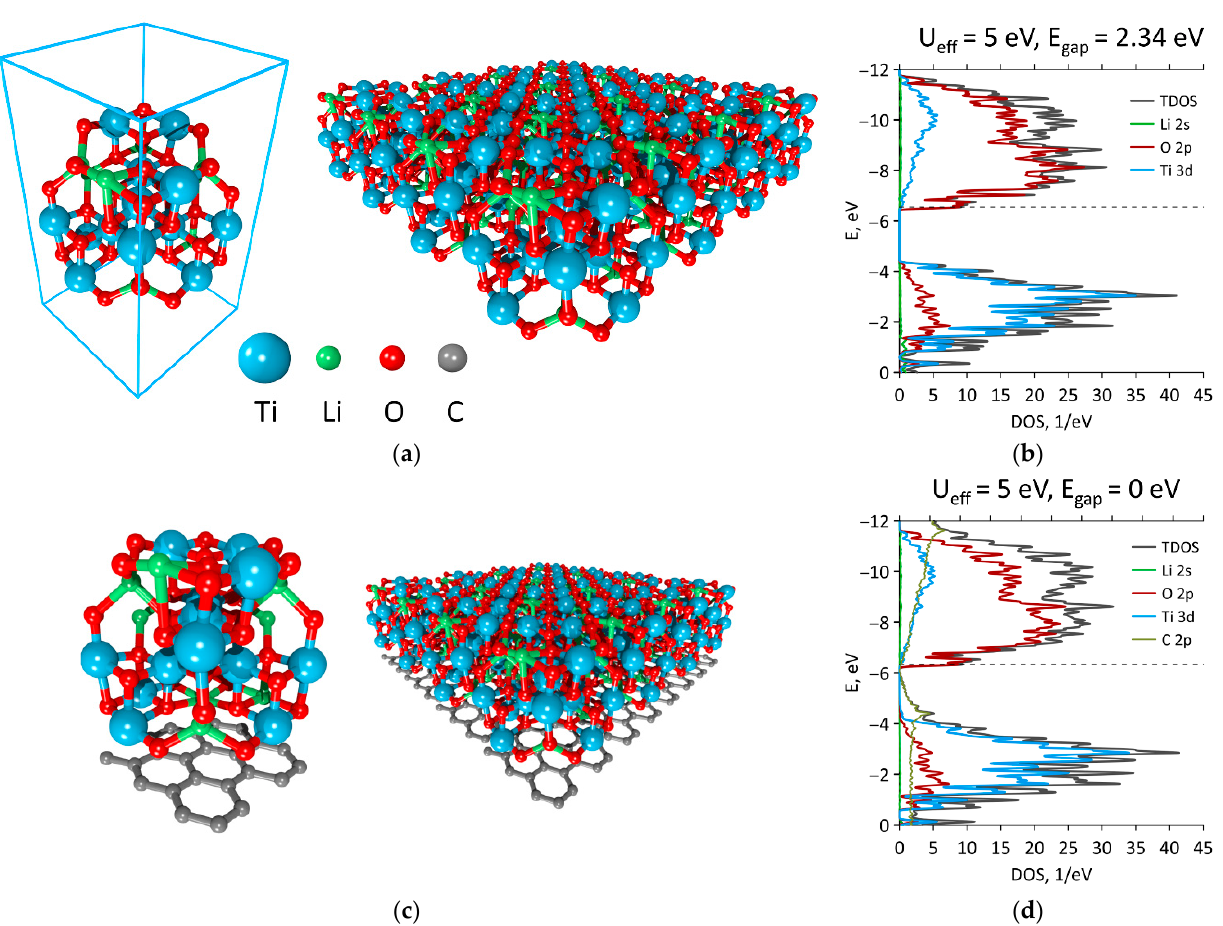
Figure 2. Two-dimensional LTO and G/LTO films: ( a ) unit cell and translated supercell of LTO, ( b ) DOS and pDOS of LTO, ( c ) supercell and translated supercell of G/LTO, and ( d ) DOS and pDOS of G/LTO.